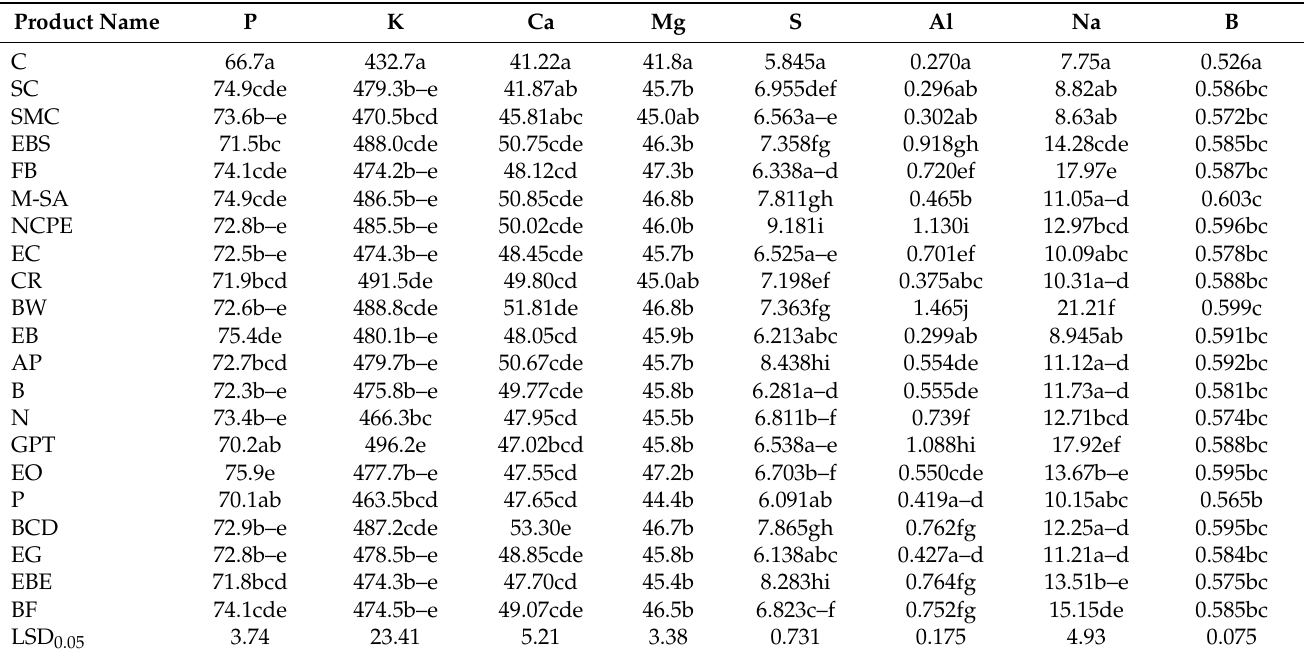
Table 4. Quantities (mg/L) of eight macro- and meso elements (P, K, Ca, Mg, S, Al, Na, and B) in white wine samples treated with twenty-one bentonite products including control treatments (Debrecen-Pallag, Hungary). Different letters within each column are significantly different among the bentonite product treatments at p = 0.05 according to LSD t-tests (LSD 0.05 ). Explanations